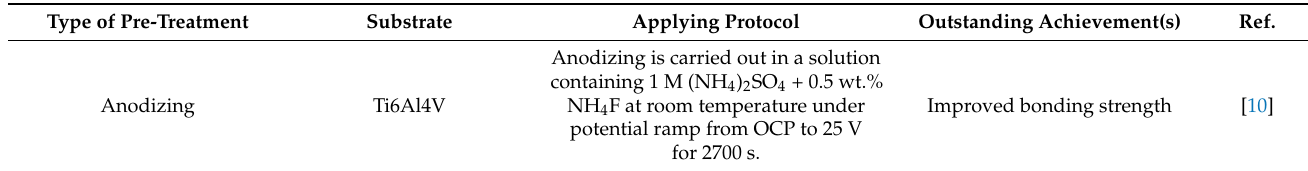
Table 6. Pre-treatments and claimed